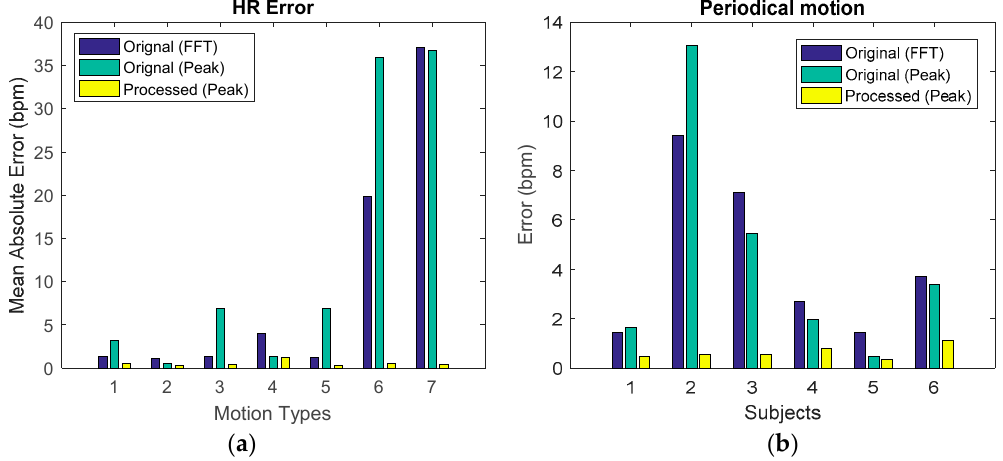
Figure 12. HR estimated in periodic motions after processing compared with preprocessing and ECG reference ( a ) HR estimation error for one subject in seven periodic motion situations. ( b ) HR estimation error for 6 subjects in periodic motion situations.